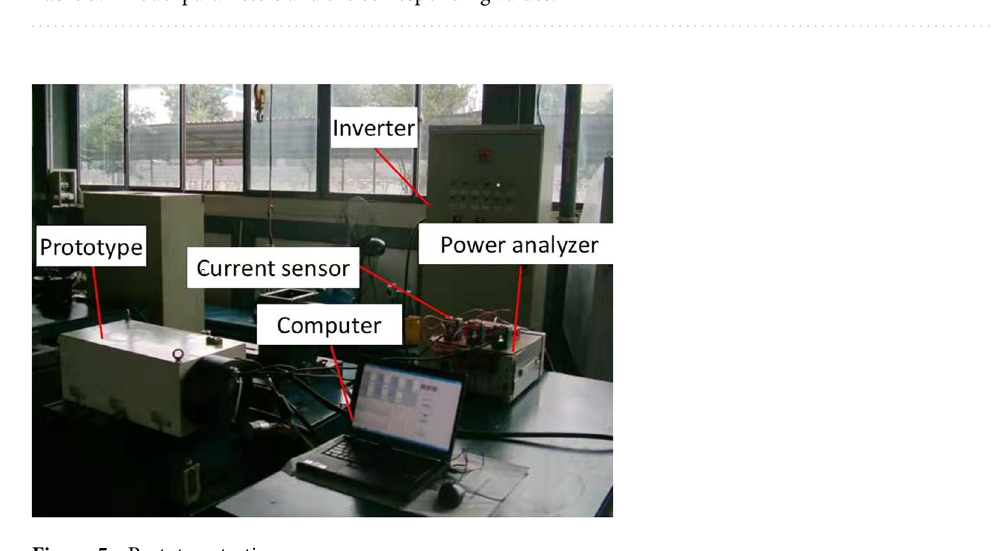
Table 3. Model parameters and the corresponding values.